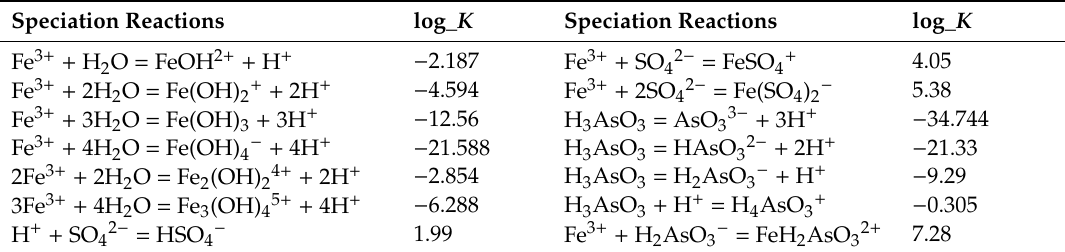
Table 1. Main speciation reactions involved in the PHREEQC